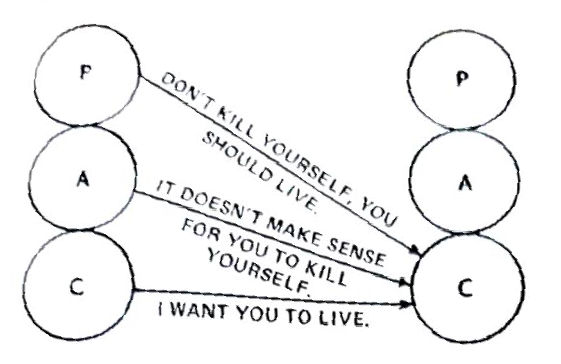
Figure 2: Permission Transaction (Woollams and Brown, 1978, p. 203).